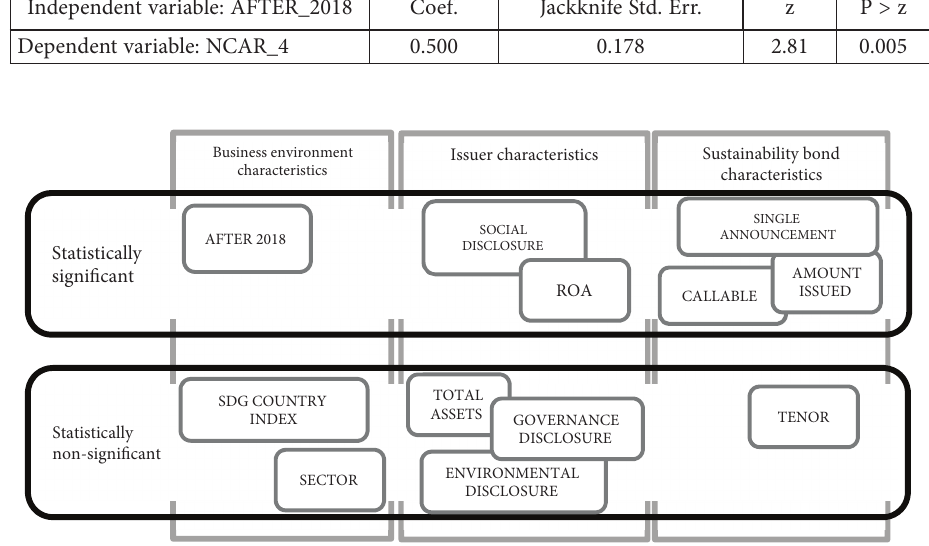
Figure 2. Drivers of wealth effects results